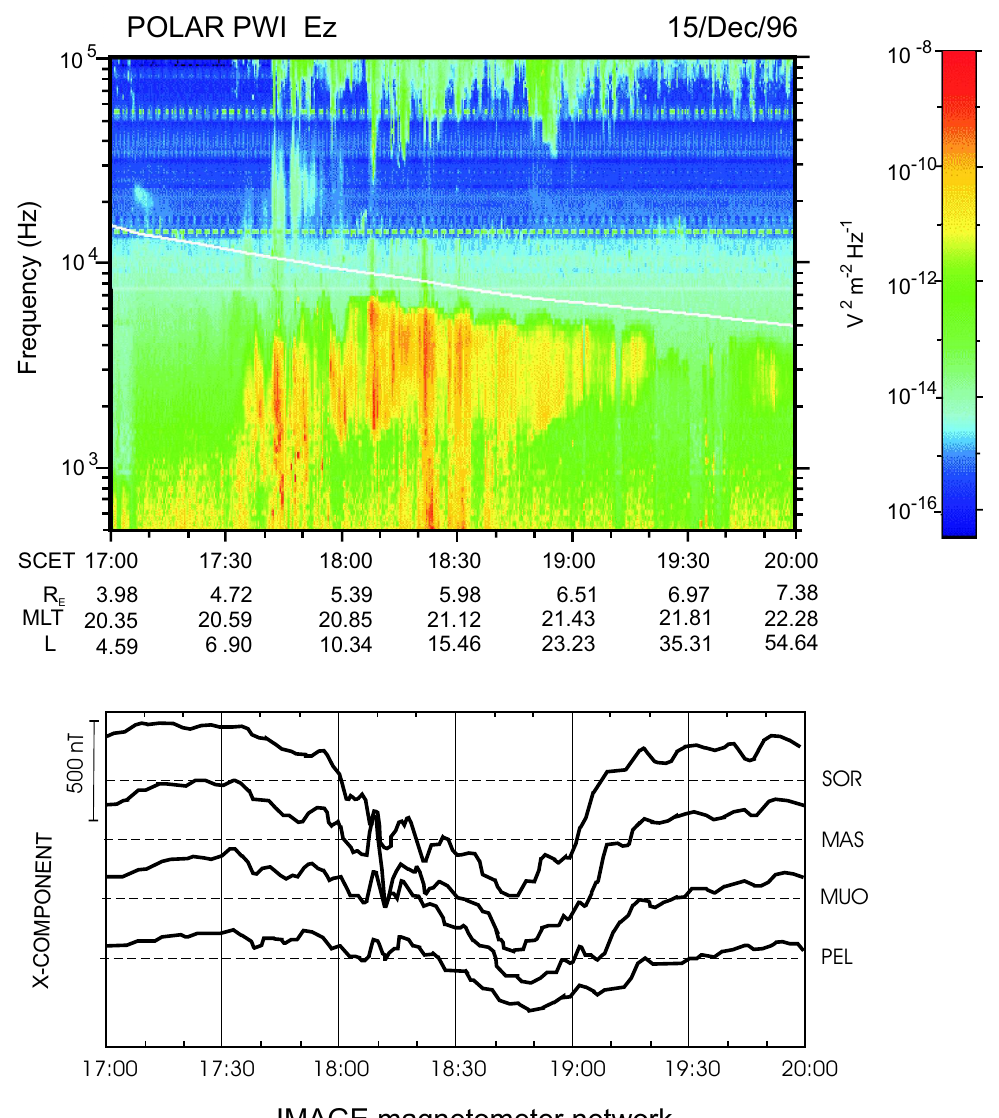
Fig. 7. Upper panel: power spectrogram of the electric field in the frequency range 5 · 10 2 –10 5 Hz recorded by the POLAR satellite on 15 December 1996. Bottom panel: magnetograms of the Scandinavian IMAGE network for 15 December 1996. The auroral hiss on board POLAR satellite occurs during a substorm magnetic disturbance registered by the IMAGE